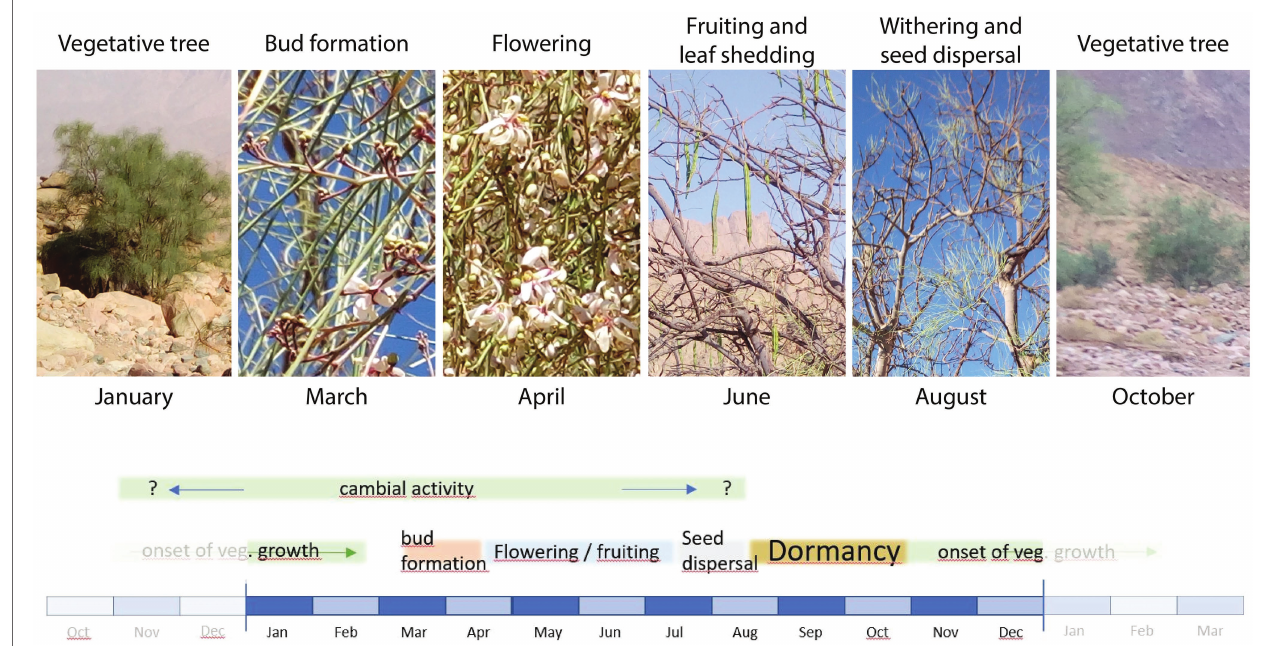
FIGURE 2 | Images indicating phenological stages of Moringa peregrina at the time of pinning. Photos were taken on January 27th, March 1st, April 11th, June 27th, August 20th, and October 27th, 2019. The lower scheme illustrates the onset and duration of these stages as well as the potential period of cambial activity based on the literature published so far.